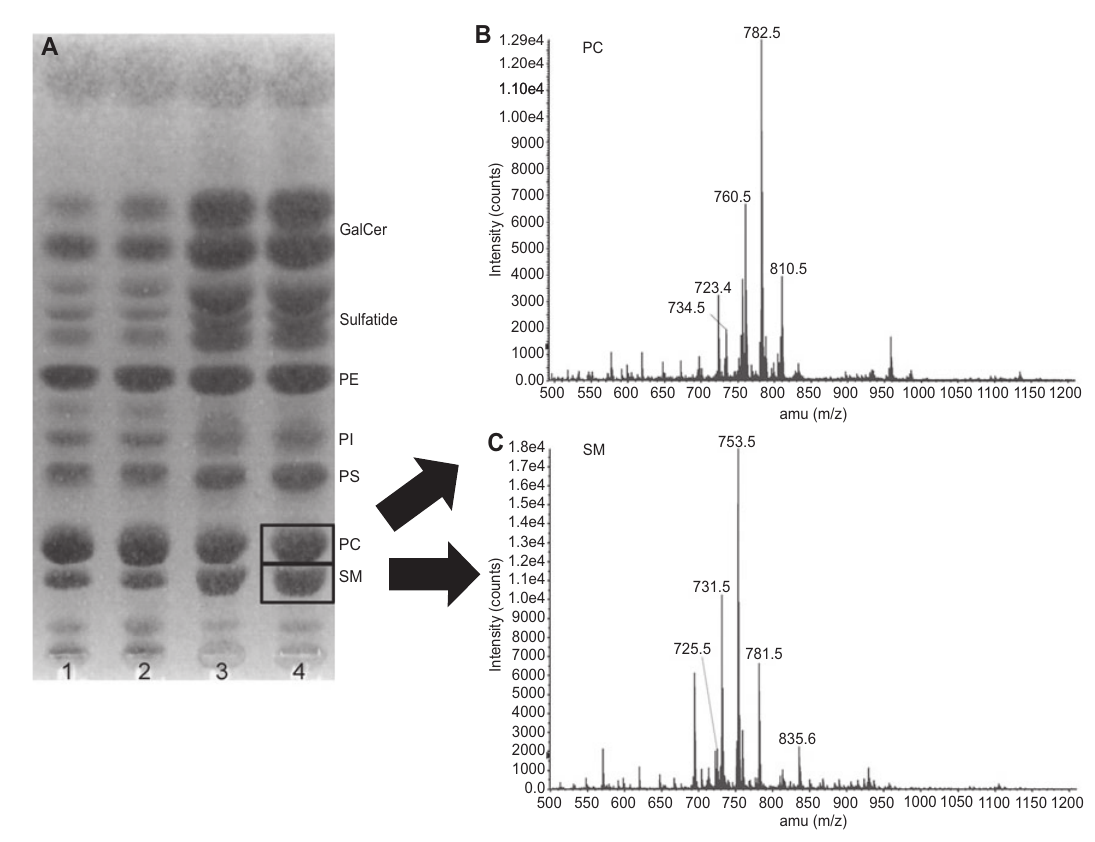
Figure 7 A typical chromatogram for quantitative determination of major PLs with the use of TLC coupled with imaging mass spectrometry: (A) Thin-layer chromatogram stained with primuline. Lanes (1 – 4) contain human brain lipid extracted from gray matter of inferior frontal gyrus (lane 1), gray matter of hippocampus (lane 2), white matter of inferior frontal gyrus (lane 3), and white matter of hippocampus (lane 4). The MS spectra of PC (B) and SM (C) allowed to directly analyze the blotted PVDF membrane. Reprinted from Journal of